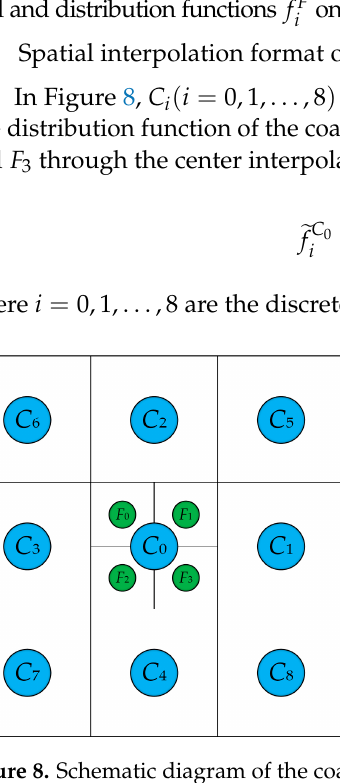
Figure 7. Schematic diagram of the interface of the coarse and fine grids in 2D.